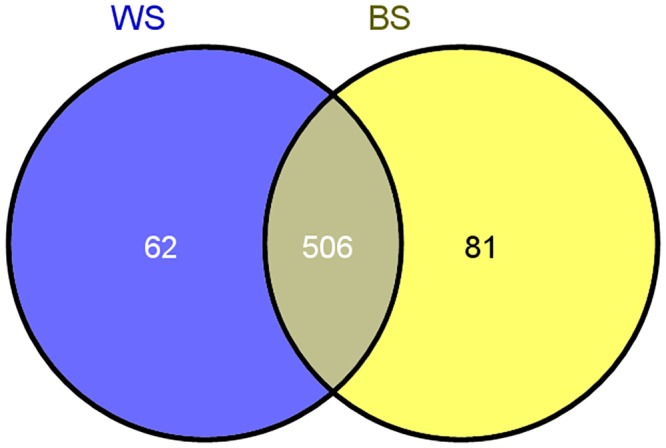
The differentially expressed genes that are unique or shared between WS and BS.WS refers to the white-skinned group. BS refers to the black-skinned group. The numbers in each section of the figure indicate the number of differentially expressed genes in the indicated comparison.